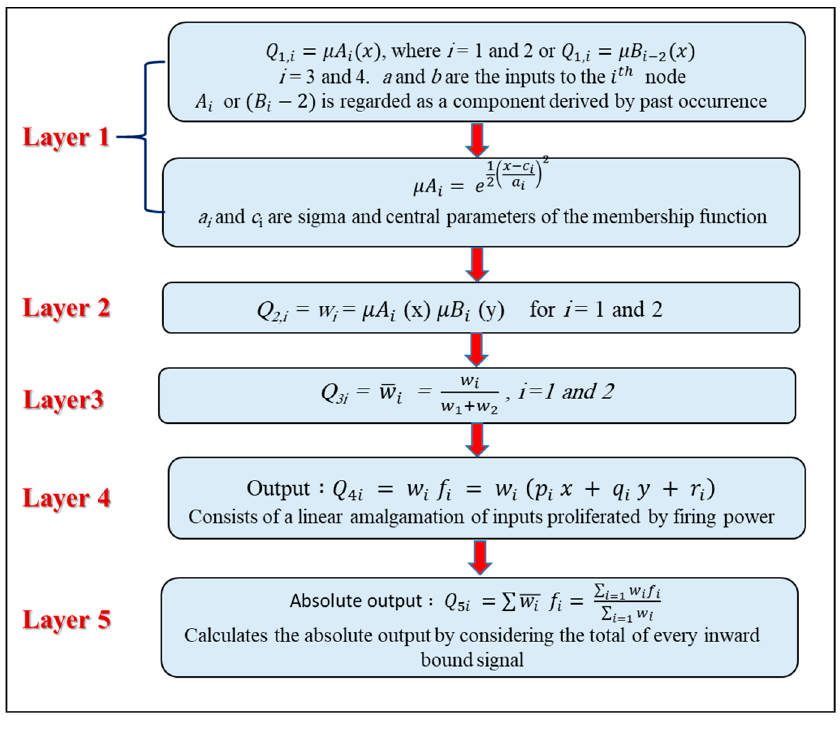
Figure 6. Schematic diagram of the five layers that incorporate ANFIS.